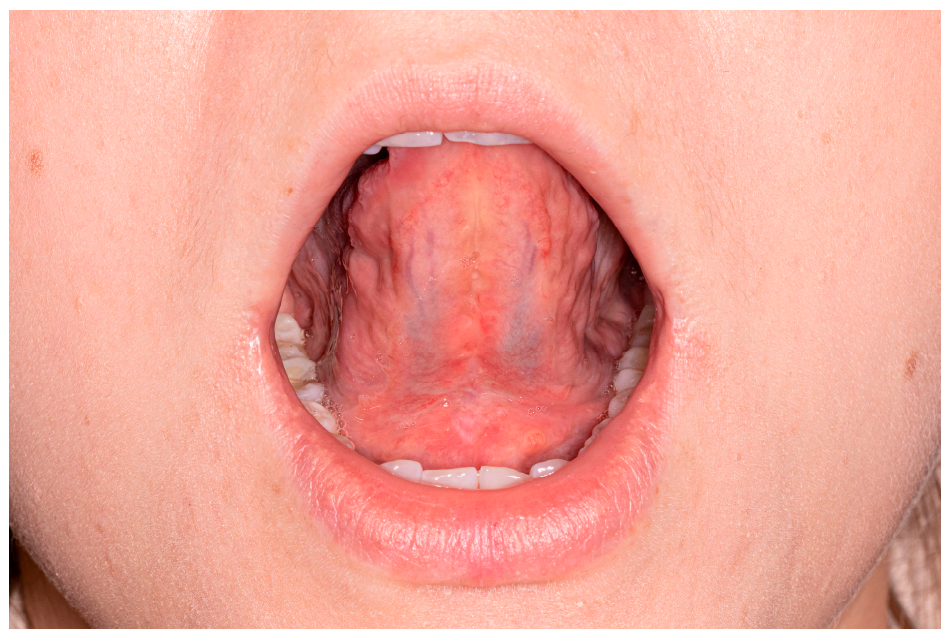
Figure 5. Final result after 1 month (TRMR-TIP 100%) .